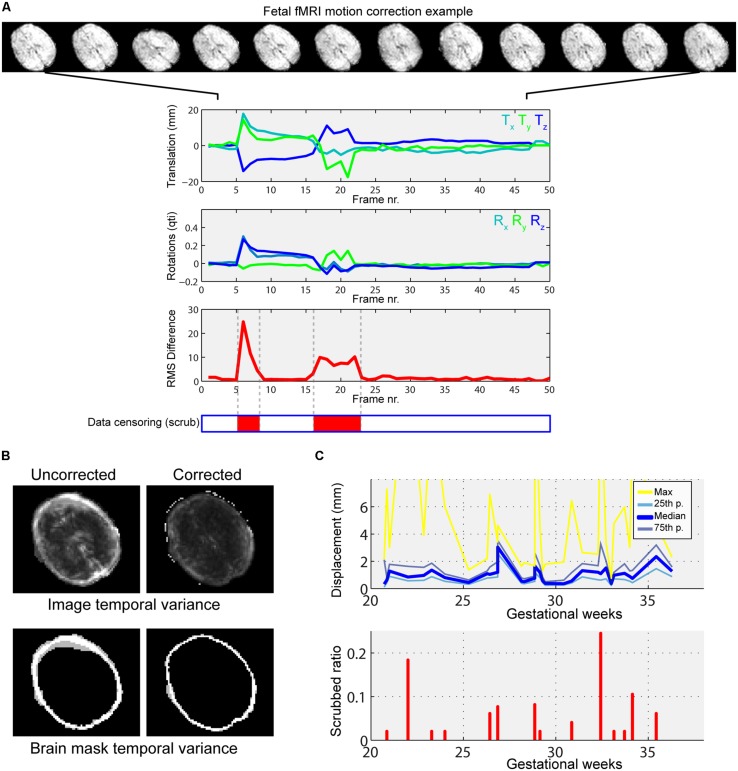
Illustration of typical fetal in-scanner head motion patterns, correlation with gestational age. (A) Fetal head motion during MR scanning is estimated by frame-to-frame linear registrations. We illustrate a fetus with excessive head movements, as indicated by the large peaks in the translation and rotational components. Total displacement was used to censor periods of the scan with large motion (middle panel, red markings). (B) The motion correction procedure reduces the temporal variance of peripheral brain voxels, as shown in the cross-sectional panels. Such regions of high, spurious temporal variance give rise to nuisance signals in the functional connectivity patterns. (C) Depiction of gestational age-dependent changes of head motion. Top: median, 25th percentile, 75th percentile and maximum displacements of the fetal head vs. GWs. Bottom: the ratio of censored data vs. GWs. In our study cohort, fetal in-scanner head motion does not show correlation with gestational age.